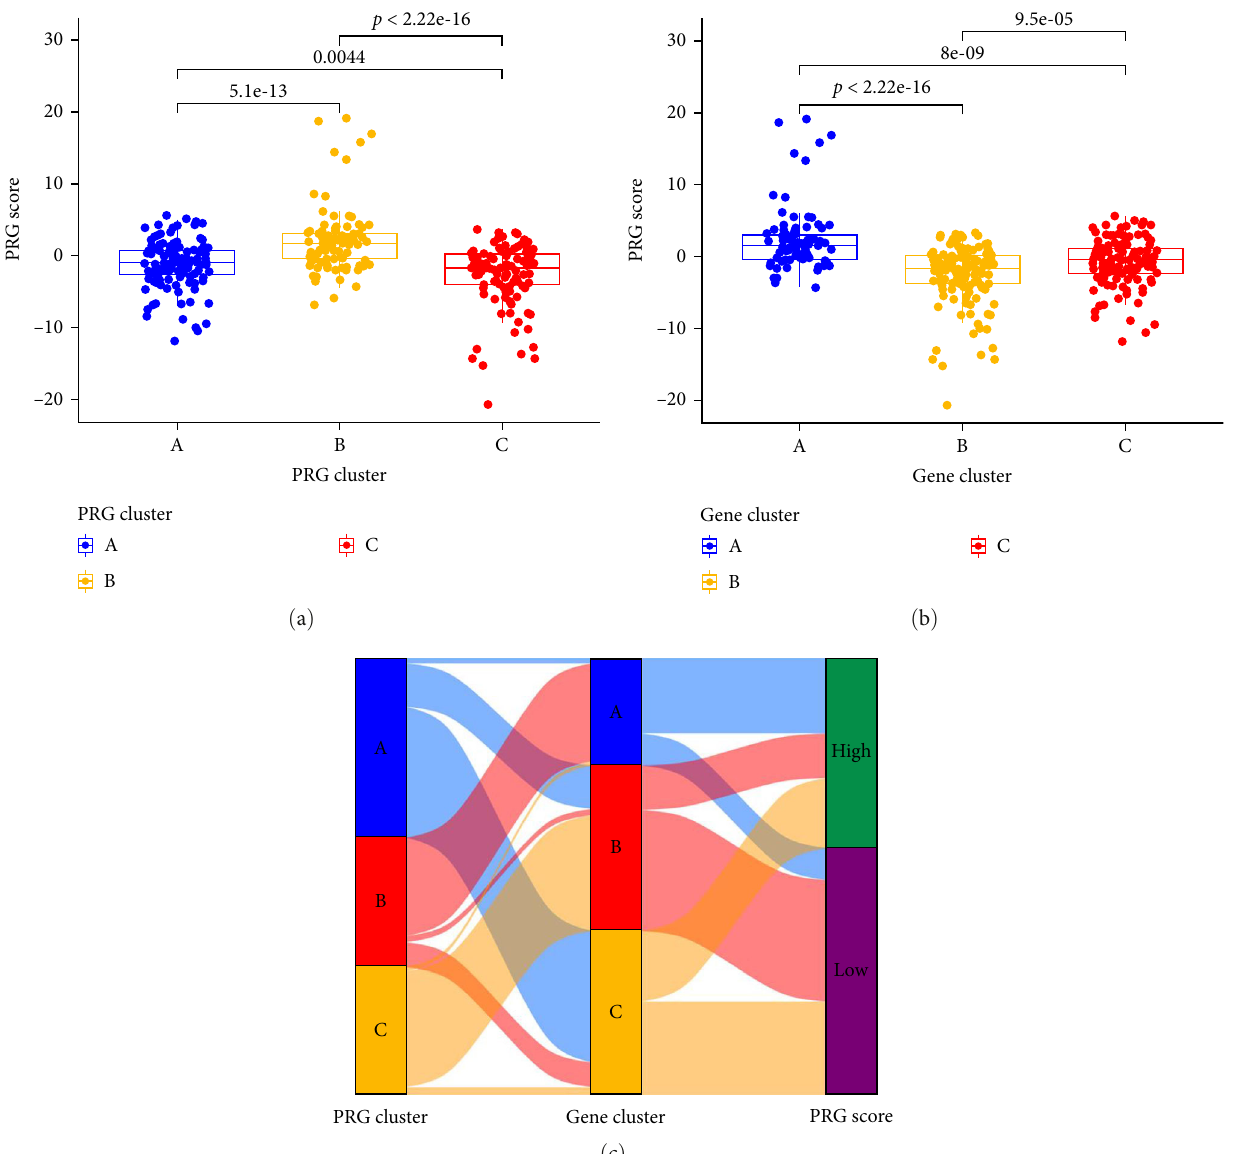
F IGURE 9: The relationship between PRG patterns, PRG gene patterns, and PRG scores. (a) Differential PRG score between distinct PRG patterns. (b) Differential PRG score between distinct gene patterns. (c) Sankey diagram showing the distribution of periodontitis samples in PRG patterns, gene patterns, and PRG scores. PRG, pyroptosis-related